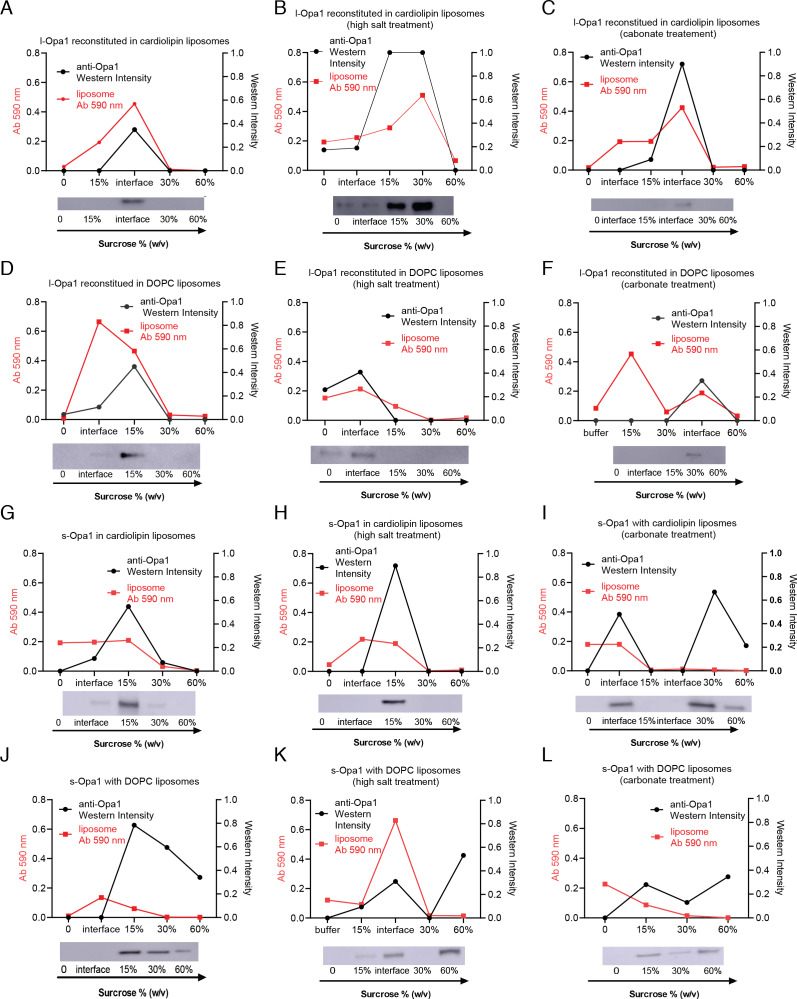
Liposome co-flotation.Liposome co-flotation analysis: Reconstituted l-Opa1 co-floats with liposomes both with and without cardiolipin (A and D). Liposomes were labeled with 0.2% (mol) TexasRed-DHPE, and their distribution was confirmed by liposome dye absorbance at 590 nm. Opa1 distribution was analyzed by western blot. Opa1/liposome fractions was mostly found near 15 ~ 30% sucrose. This reconstitution is stable under high salt (B and E) or carbonate conditions (C and F). s-Opa1 interacts with liposomes in a cardiolipin-dependent manner (G-L). This interaction is resistant to high salt (H) but sensitive to carbonate treatment (I), where the protein was found in the bottom fractions lacking liposome (60% sucrose). s-Opa1 does not associate with DOPC liposomes (J-L). These results indicate that l-Opa1 was successfully reconstituted through integral transmembrane region, whereas the s-Opa1 bilayer-association is through a cardiolipin:s-Opa1 peripheral membrane interaction.Figure 2—figure supplement 2—source data 1.Liposome co-flotation.